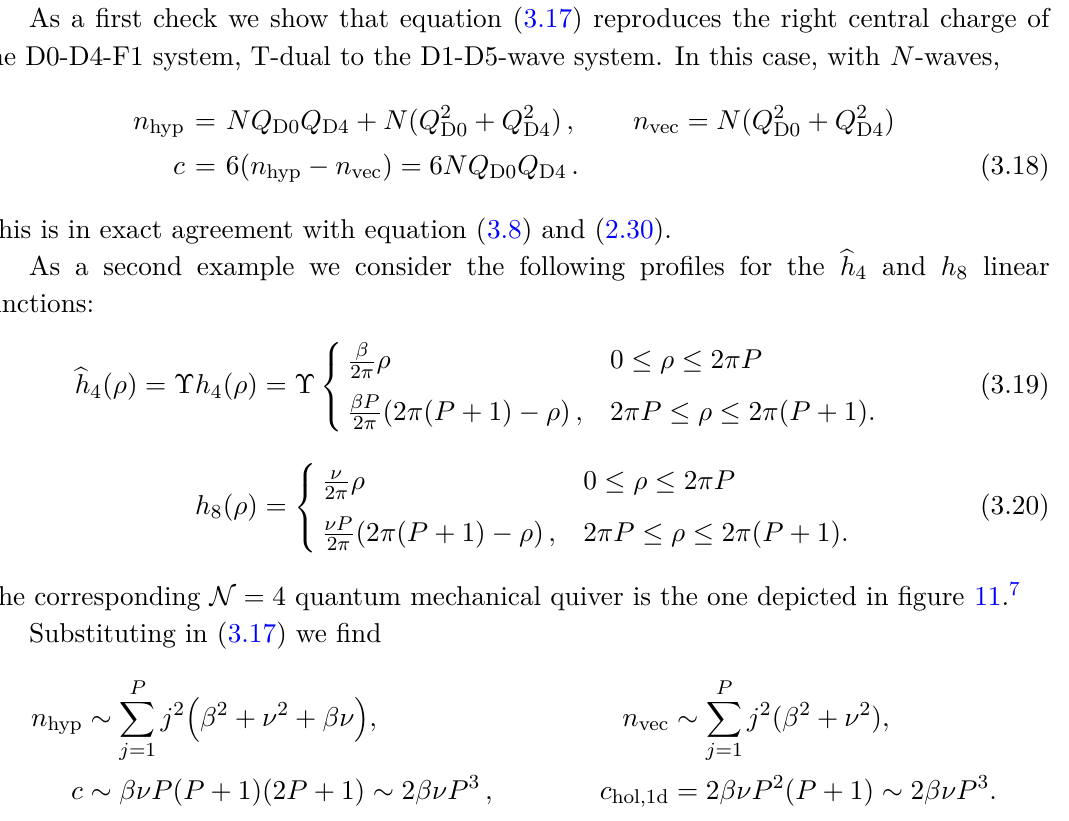
holographic calculation for long quivers with large ranks. We show next that equation (3.17) matches as well the holographic result for the quiver quantum mechanics defined in the previous subsection, not originating from 2d CFTs. For these quivers n numbers of N = (0 , 4) hypermultiplets and N = (0 , 4) vector multiplets of the quantum